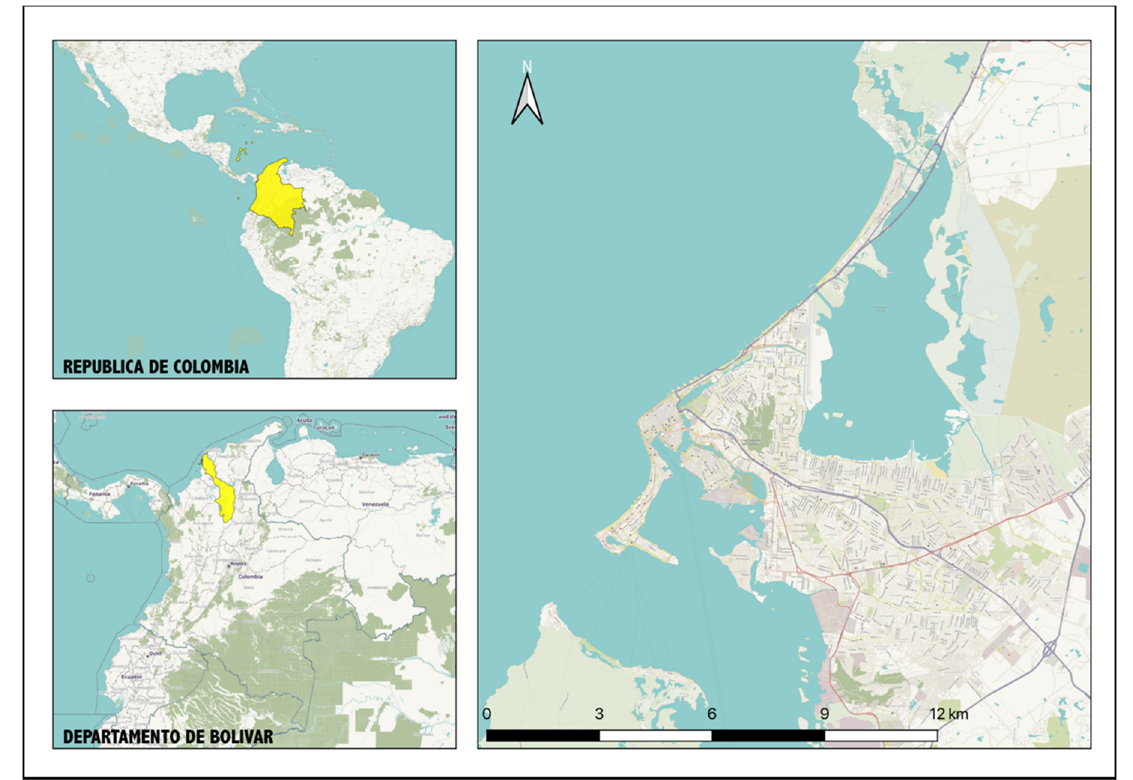
Figure 1. Location of the study area.